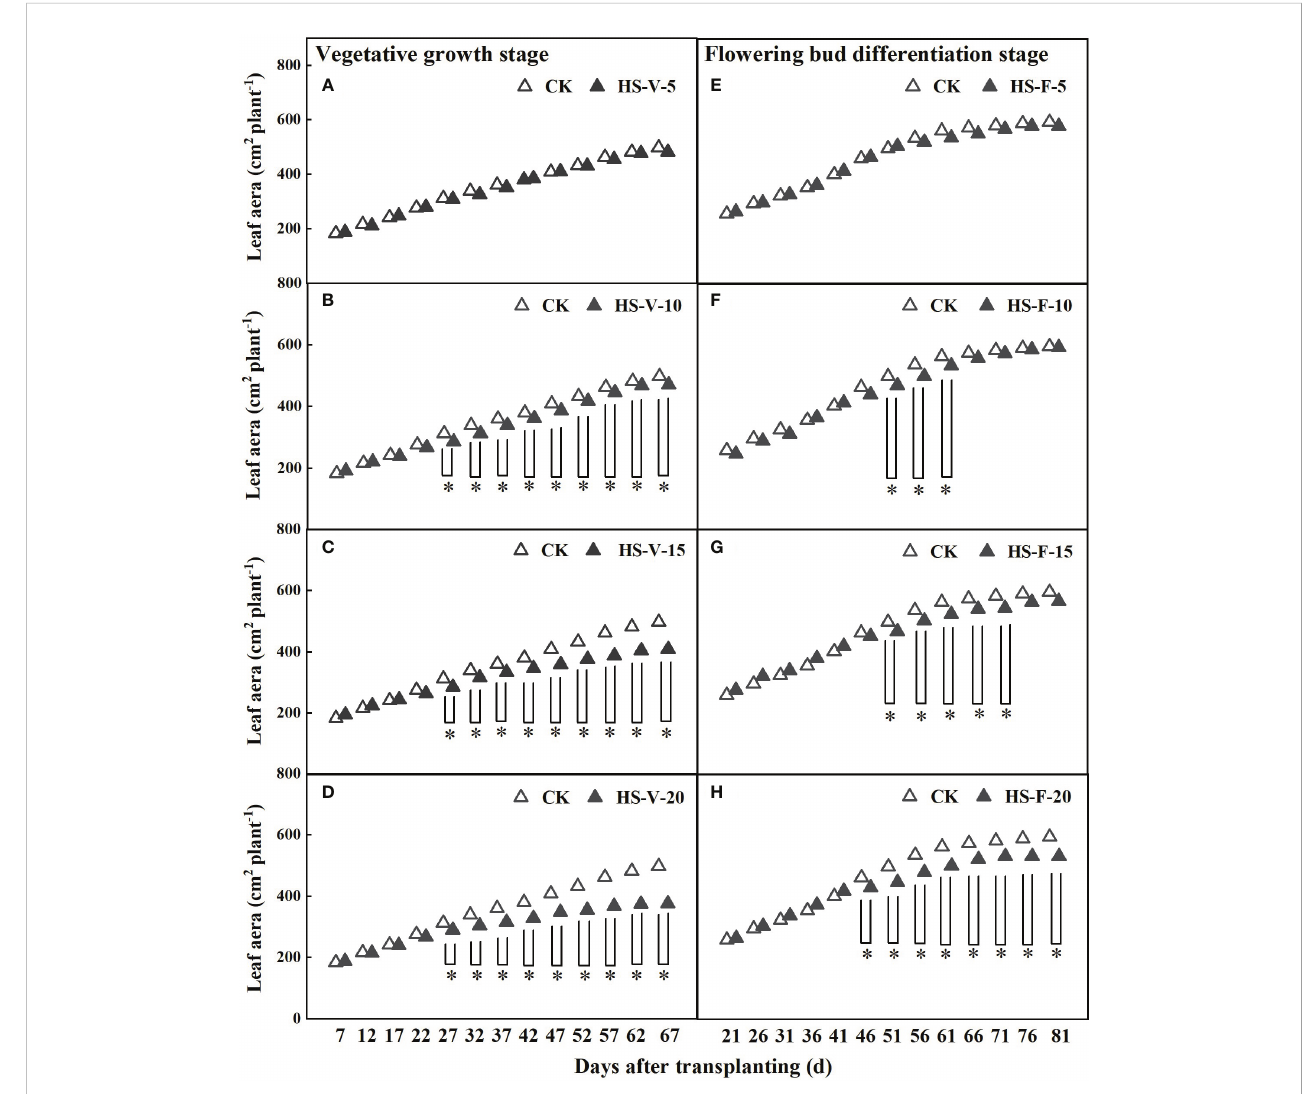
FIGURE 3 Dynamics of leaf area under different temperature treatments during the vegetative growth (A – D) and fl owering bud differentiation stages (E – H) . CK is the control treatment, HS is the heat stress treatment. Values are the mean ± SD (n=3). *indicates the signi fi cant level at P